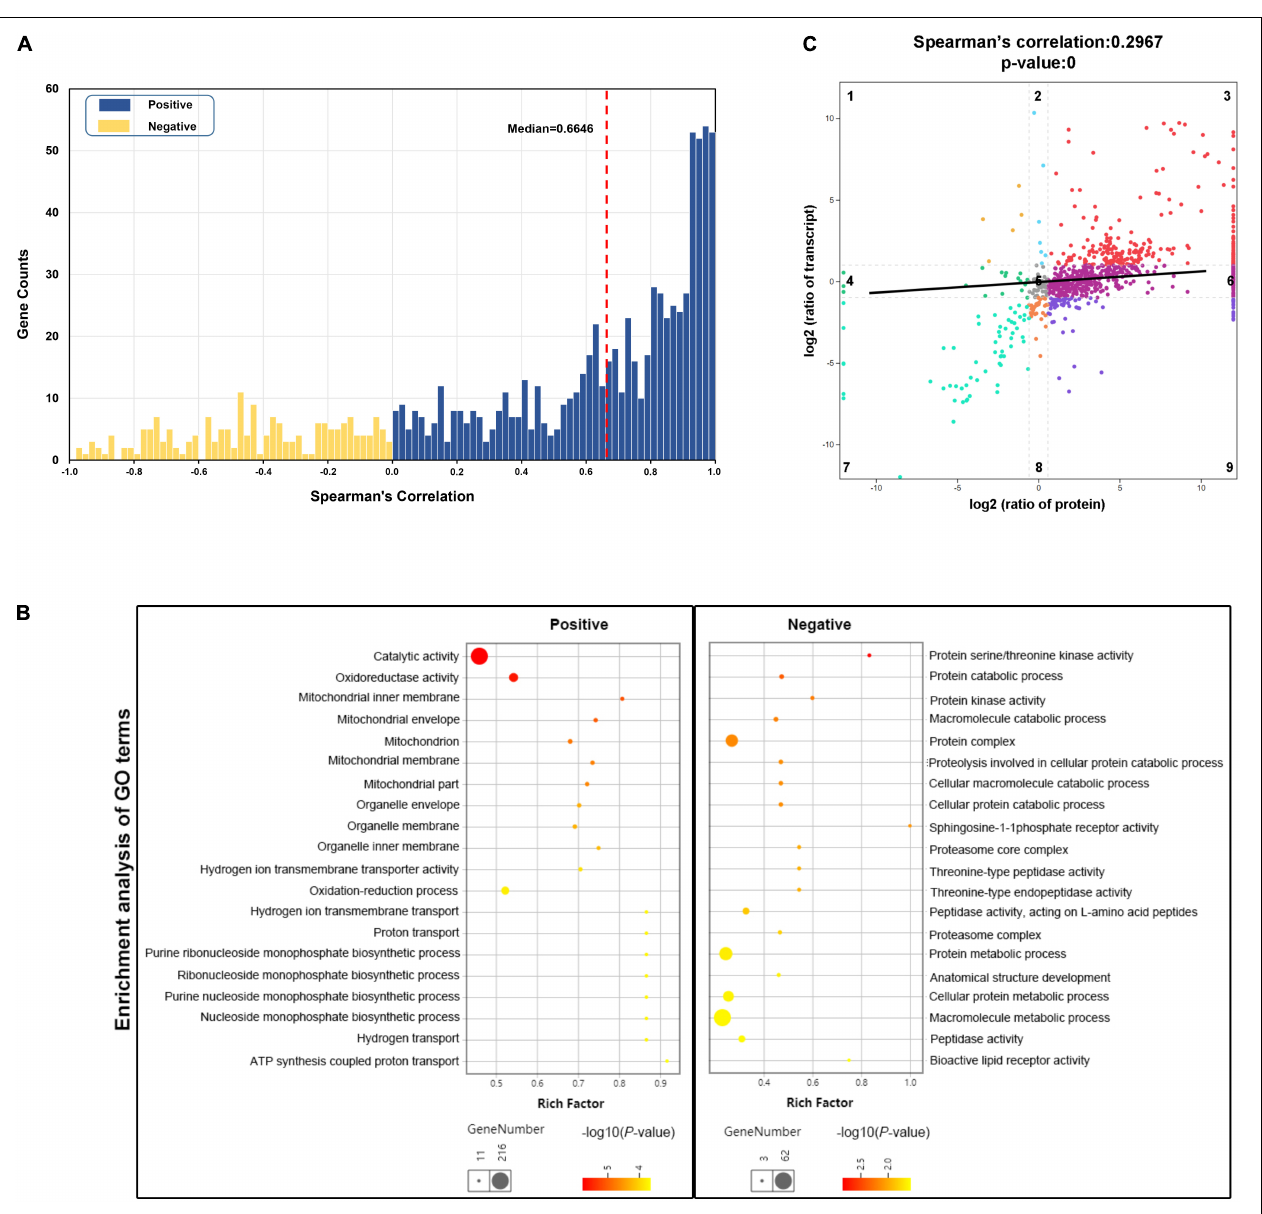
FIGURE 5 | Integrative analysis of transcriptomic and proteomic data. (A) Correlation between RNA and protein abundance for 948 RNA-protein pairs across six samples. Blue bars represent positively correlated RNA-protein pairs ( n = 757), while yellow bars represent negatively correlated ( n = 191). The red dashed line represents the median value of Spearman’s correlation coefficient. (B) Gene Oncology (GO) enrichment analysis of the strong positively correlated genes ( n = 366, Spearman’s correlation coefficient > 0.8) and negatively correlated genes ( n = 191). The rich factor of x-axis indicates the number of enriched genes associated with the given GO term divided by the total number of input genes. (C) Correlation of fold change in protein abundance against RNA expression for all RNA-protein pairs. The black line represents linear curve fitting. Dots in the first, third, seventh, and ninth quadrants represent the genes with significant changes in both RNA (fold change ≥ 2) and protein expression (fold change ≥ 1.5). Dots in the second and eighth quadrants denote significant changes in RNA expression levels only. Dots in the fourth and sixth quadrants only show significant changes in protein expression levels. Dots in the fifth quadrant represents no significant changes in either RNA or